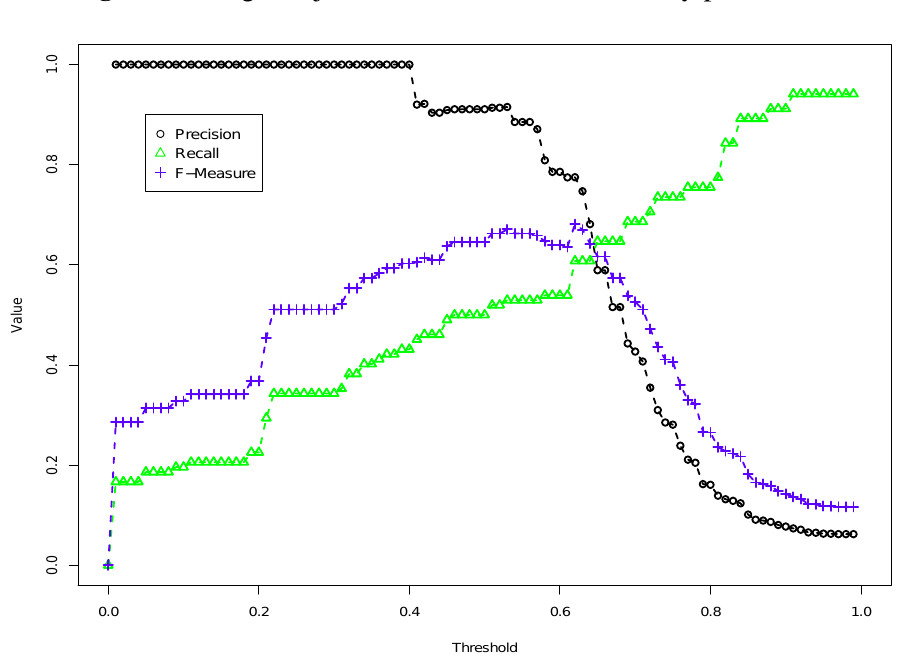
Figure 2. Length adjusted Levenshtein dissimilarity